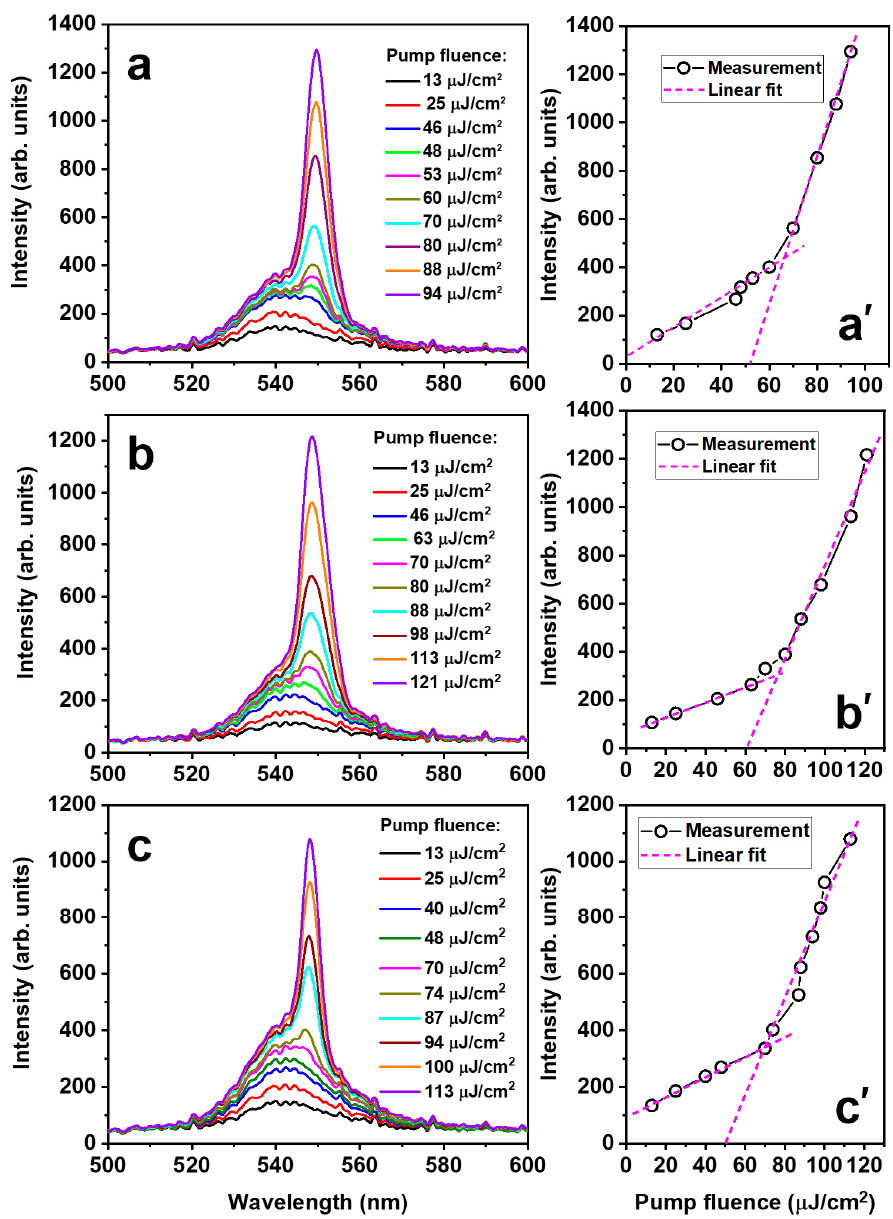
Figure 5. Random lasing performance (emission spectra and lasing threshold) of the MAPbBr 3 crystalline gridding at different periods: ( a ) Λ = 50 µ m; ( b ) Λ = 20 µ m; ( c ) Λ = 10 µ m. ( a’ – c’ ) Emission intensity at about 550 nm as a function of the pump fluence, corresponding to ( a – c ),